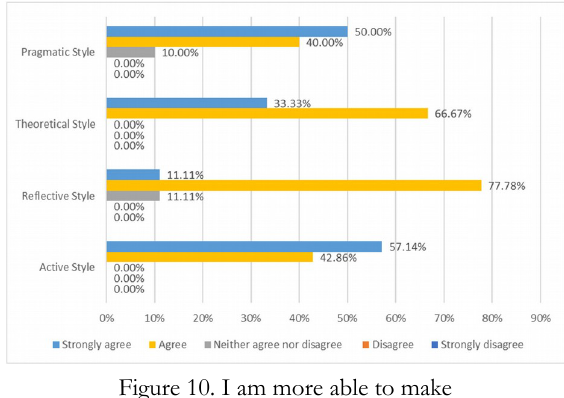
Figure 10. I am more able to